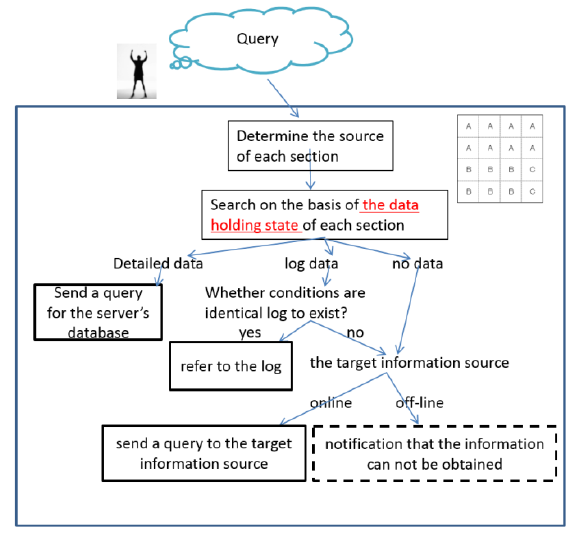
Fig. 5. Selection of information sources.